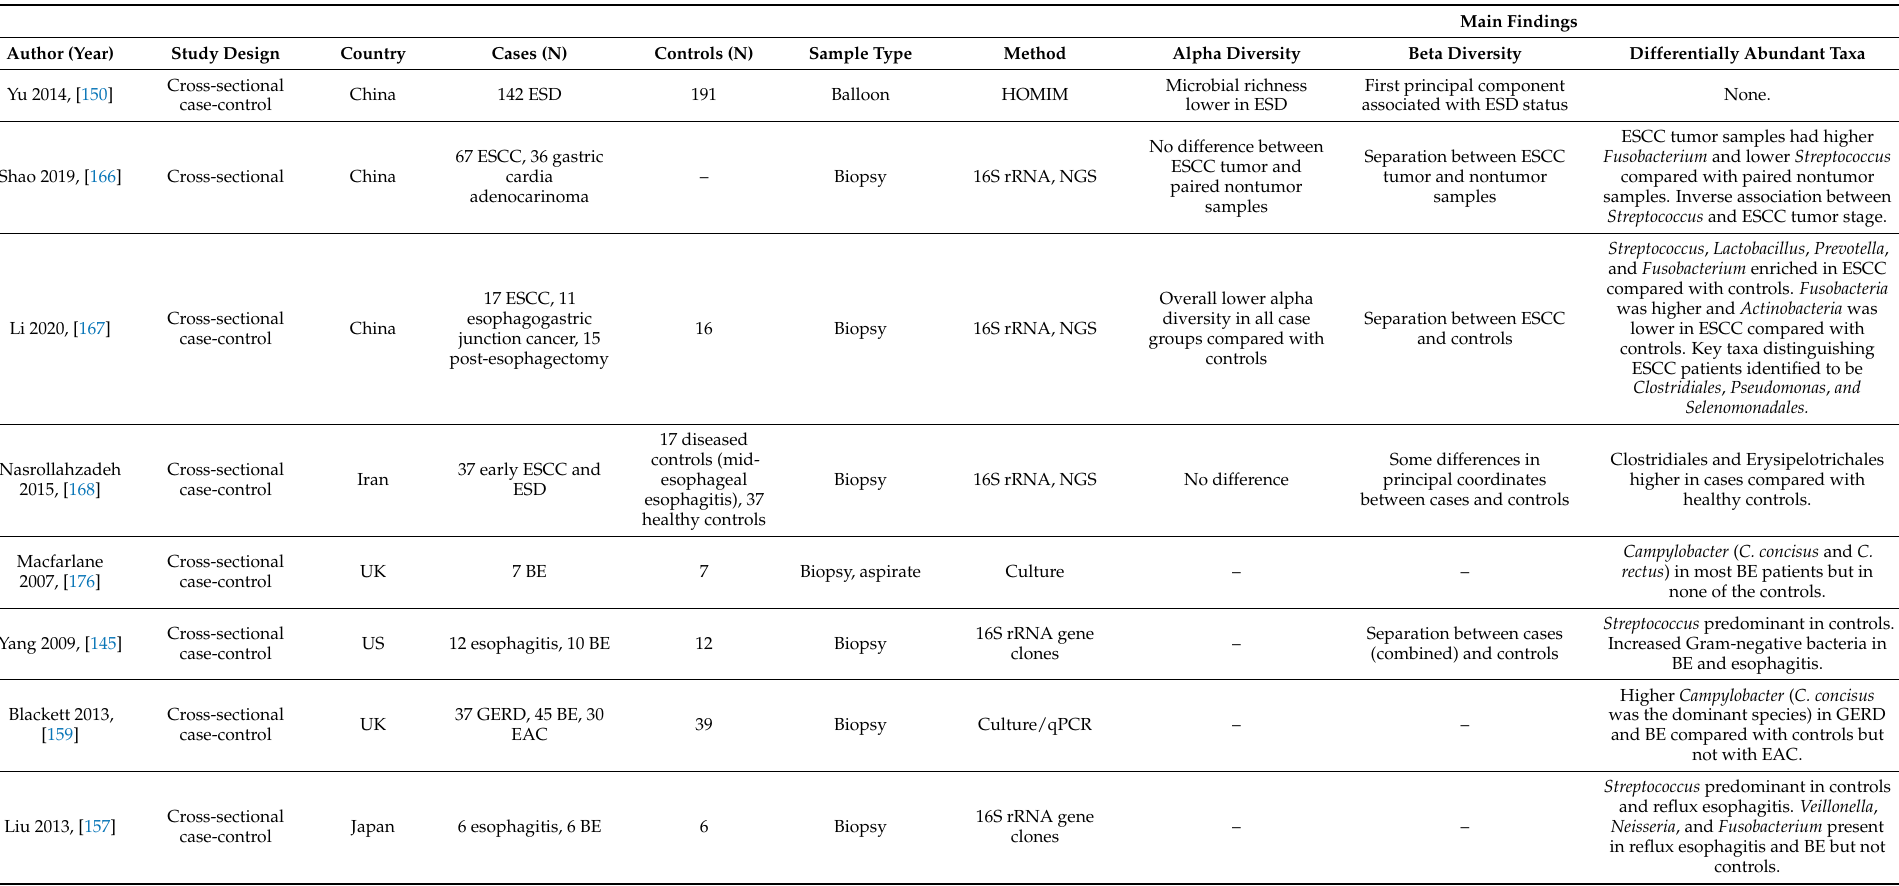
Table 2. Studies of the esophageal microbiome and esophageal